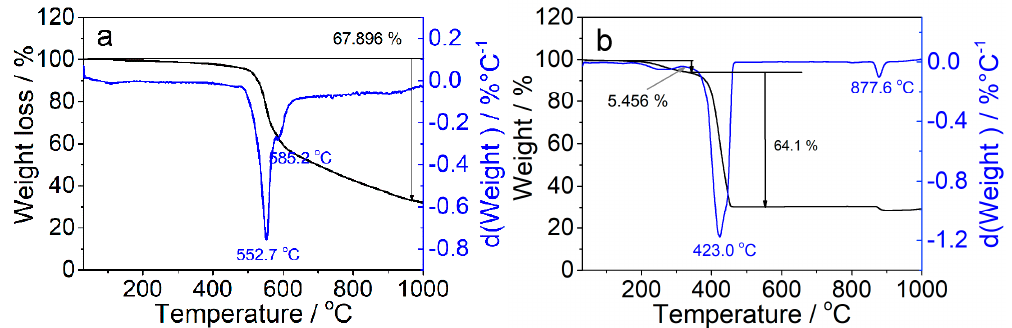
Figure 6. Thermogravimetric analysis (TGA) (black lines) and differential TGA curves (blue lines) of ZIF-67 ( a ) and ZIF-67-IL ( b ).